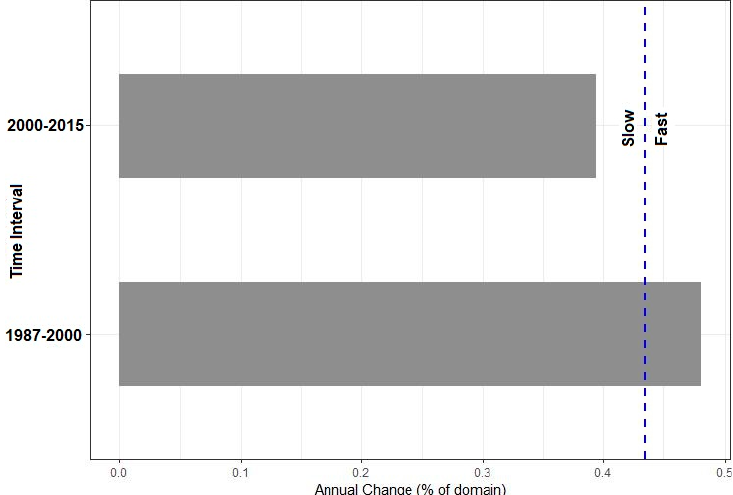
Figure 8. Time interval change intensity for the periods 1987–2000 and 2000–2015.